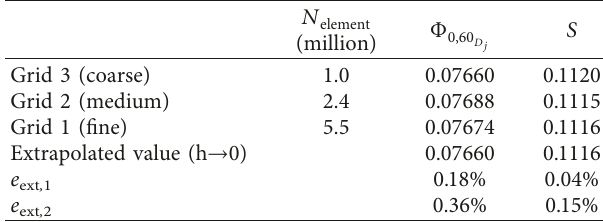
� 0.0015m. j from steady state simulation with D j Table 1: Grid information and Richardson extrapolation results with three grids and steady state